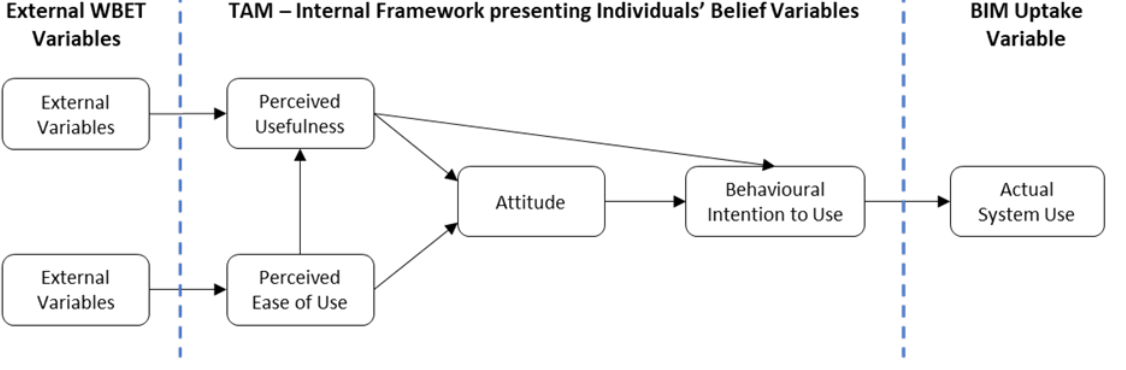
Figure 1. Technology Acceptance Model (TAM) [22].